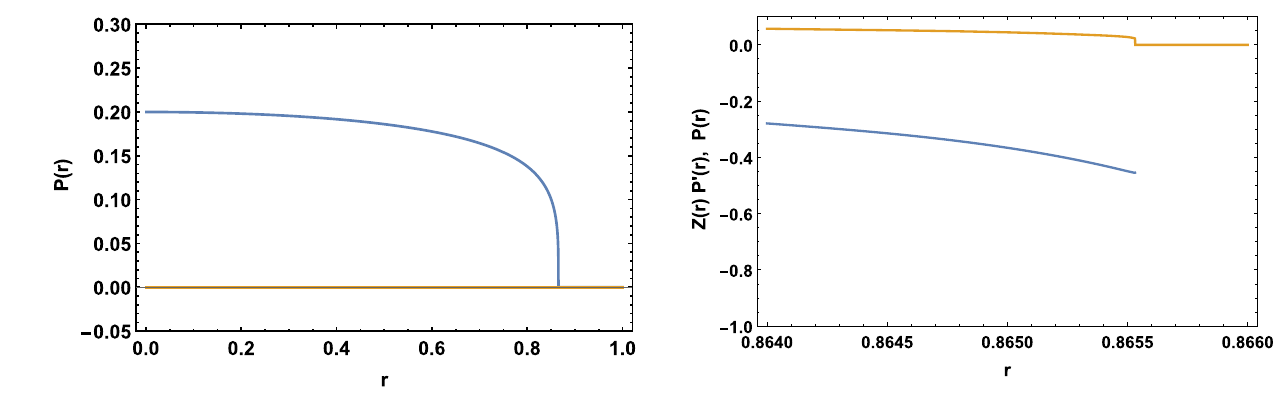
Fig. 3 The pressure of the configuration tends to contract the elastic body increasingly as the symmetry centre is approached. However, this behaviouriscurious,becausethegravitationalpotentialdecreaseswhen movingawayformthecentre,attractingthemattertotheboundary.This propertymeansthatsincetheforcesdeterminedbythefield-matterinter- action oppose the repulsing gravitational forces and overcome them, they lead to a net contraction. Since the parameters can be varied, this property can be different for other sets of values